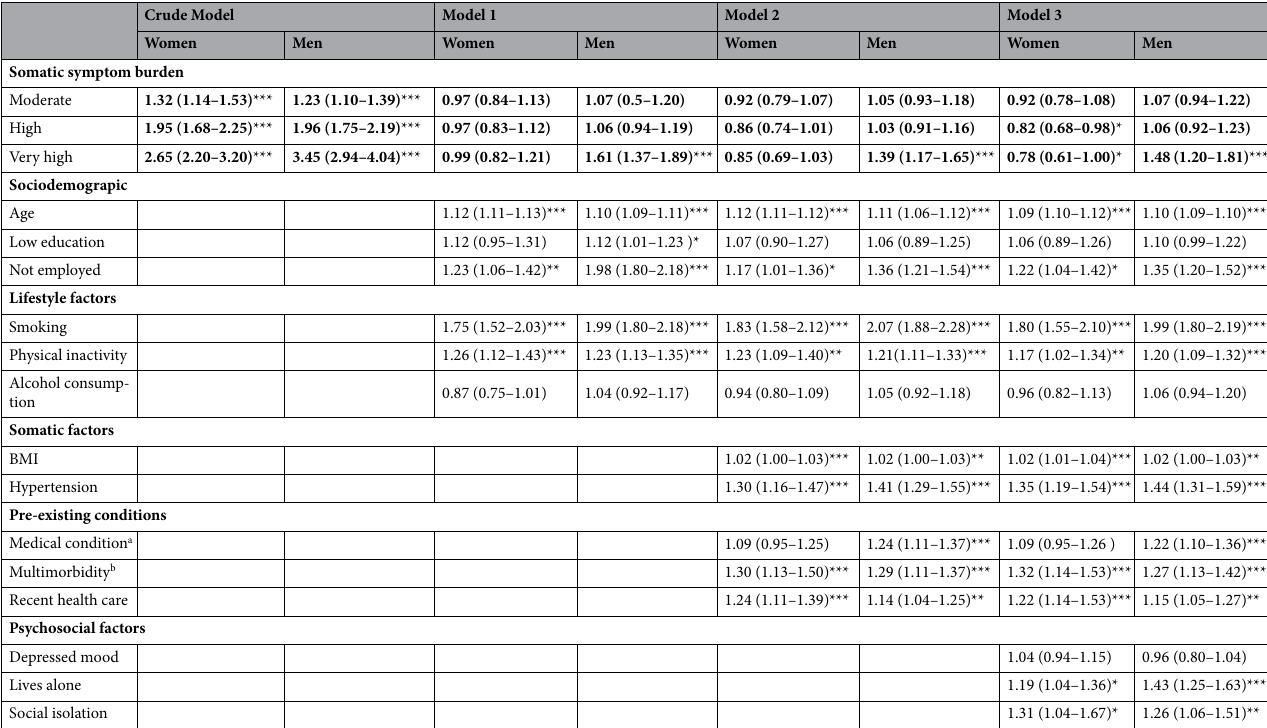
Table 2. Adjusted Hazard ratios (95% CI) of all-cause mortality in women (n = 5679) and men (n = 5861) according to somatic symptom burden in reference to participants with a ‘low’ somatic symptom burden, and the effect of concurrent risk factors within this association in the MONICA/KORA cohort (N = 11.540). a 1 pre-existing medical condition’. b ≥ 2 pre-existing conditions (multimorbidity). * p < 0.05, ** p < 0.01, *** p < 0.001. Values in [bold] indicate the exposure variable.